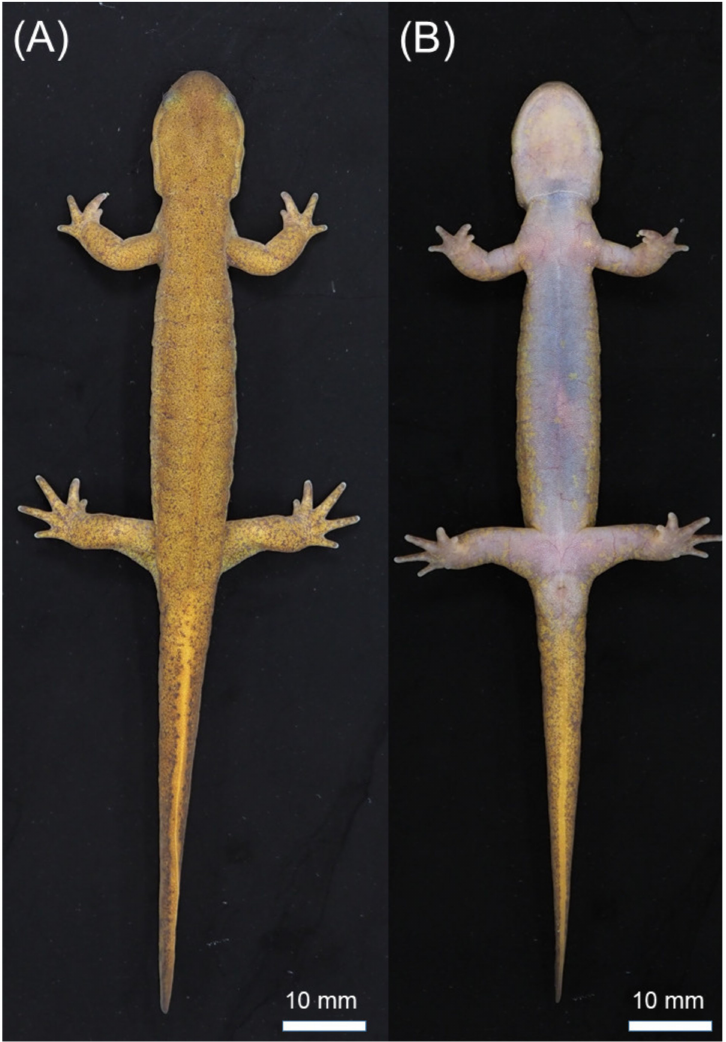
Figure 4. Holotype of Hynobius kunibiki sp. nov. (TRPM-ARA-0000014, adult male): ( A ) dorsal and ( B ) ventral views.